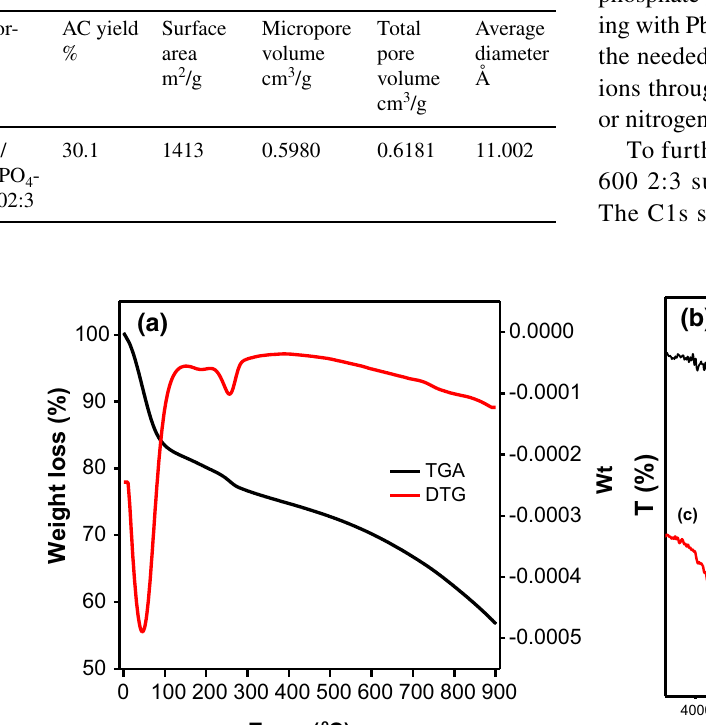
Table 1 Apparent surface area and porosity structural parameters for